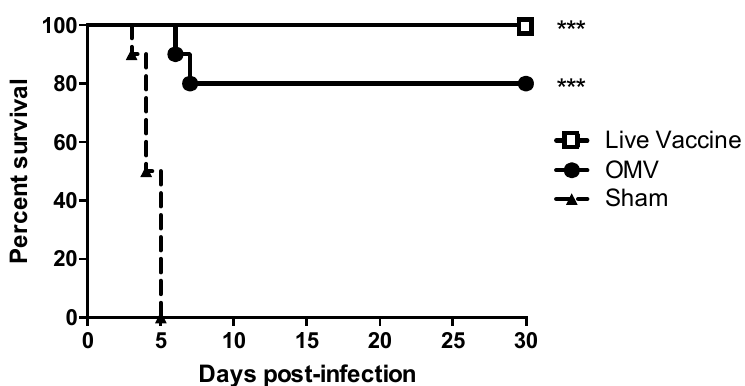
Figure 1. Immunization with B. pseudomallei outer membrane vesicles (OMVs) protects mice against pneumonic glanders. Mice ( n = 10 per group) were challenged with 1246 cfu of B. mallei by small particle aerosol. Survival was monitored for up to 30 days. Mice immunized with OMV or live vaccine were significantly protected (*** p < 0.001 as determined by Log Rank Mantel–Cox test).